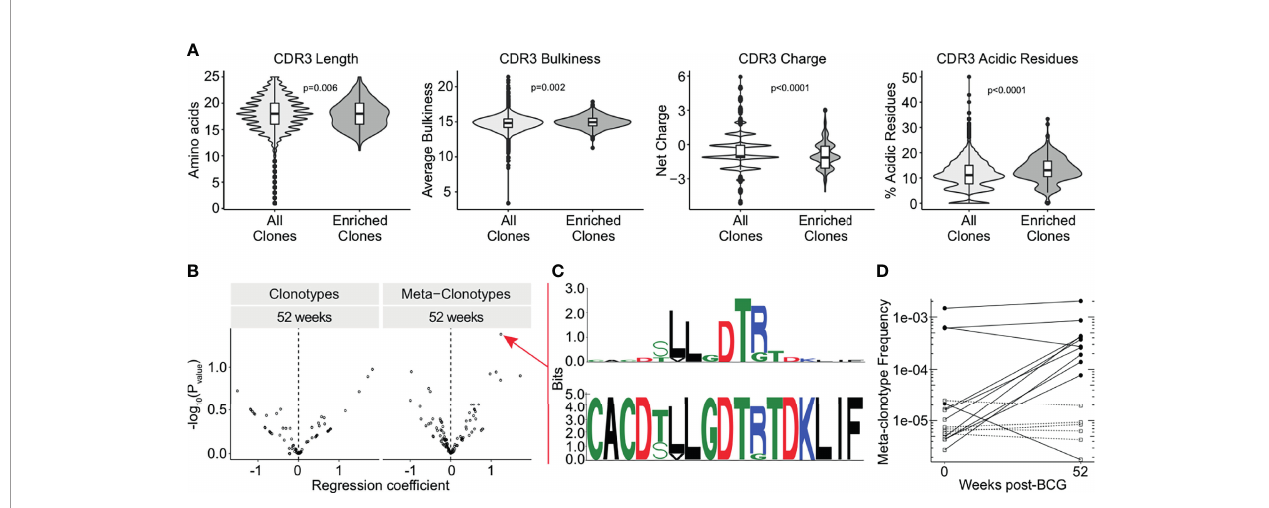
FIGURE 4 | TCR- d meta-clonotypes reveal a donor-unrestricted signature of BCG revaccination. Sequences of expanded clones were analyzed for CDR3 biochemical properties and sequence motifs. (A) CDR3 length (left), bulkiness (middle left), charge (middle right), and acidic residues (right) were assessed within TCR- d expanded clones compared to CDR3 regions from all TCR- d sequences (Wilcoxon rank-sum test with Benjamini-Hochberg correction for multiple hypothesis testing, n = 51,723 sequences). (B) Testing for association of TCR- d features with post-vaccination time point in bulk repertoires of 17 BCG revaccinated individuals. Volcano plots show beta-binomial regression coef fi cient estimates (x-axis) and -log10 P values (y-axis). Positive coef fi cient estimates indicate clonotype or meta- clonotype more likely to be detected at 52 weeks post-revaccination compared to pre-revaccination. (C) CDR3 sequence motif of the most signi fi cantly post-vaccine associated meta-clonotype TCR feature, quanti fi ed as the sum of templates in the repertoire within 18 TCRdist units from centroid sequence and matching the motif pattern. The top sequence logo shows the information relative to amino acids found in a background set of randomly sampled TRDV2*01 and TRDJ*01 CDR3 sequences. (D) Meta-clonotype frequency (y-axis) in 0 weeks and 52 weeks post-revaccination samples. Empty square symbols denote non-detections plotted at 1/ 10th the minimum sample frequency (a function of each sample ’ s sequencing depth). Dashed lines indicate samples where the meta-clonotype was not detected in either the pre- or post-vaccination sample. Black circles indicate samples where the meta-clonotype was detected, and white squares indicate samples where the meta-clonotype was not